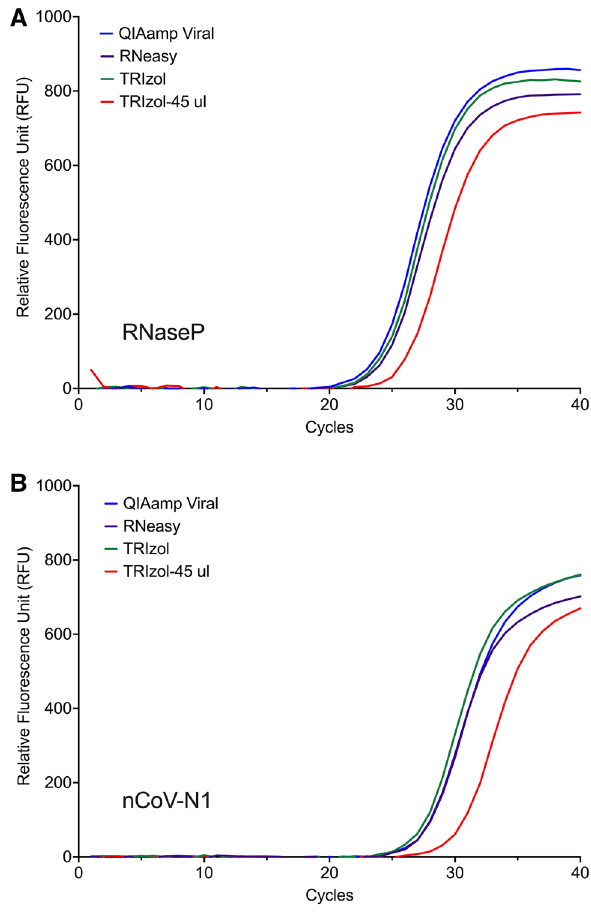
Figure 3. Efficiency of TRIzol RNA extraction relative to commercial kits. RNA was isolated from swab samples spiked with heat inactivated 2019 novel coronavirus (nCoV) using the Qiagen QIAamp Viral RNA kit, Qiagen RNeasy Mini Kit, standard TRIzol-based method performed manually, or semi-automated, 96-well- adapted TRIzol-based protocol by Eppendorf epMotion. SYBR-based amplification curves for ( A ) human Ribonuclease P, and ( B ) SARS-CoV-2 N1